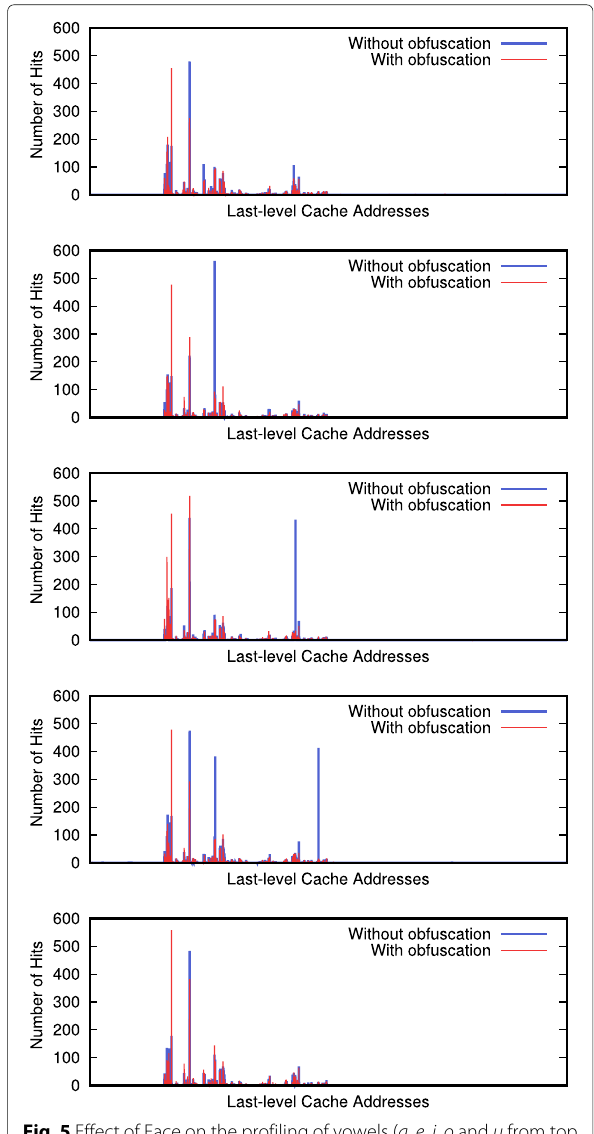
Fig. 5 Effect of Face on the profiling of vowels ( a , e , i , o and u from top to bottom). The graphs show the number of hits for each address in the last-level cache (approximately 16,000 addresses) with and without obfuscation. The bars are concentrated in the region which is used by the GDK library for keypresses. As we can see, obfuscation changes the profiles considerably and also makes them indistinguishable. The normal profiles of the five vowels can be easily differentiated, but the obfuscated profiles of multiple vowels look the same. The blue bars have been drawn slightly wider for clarity during overlaps with the red ones